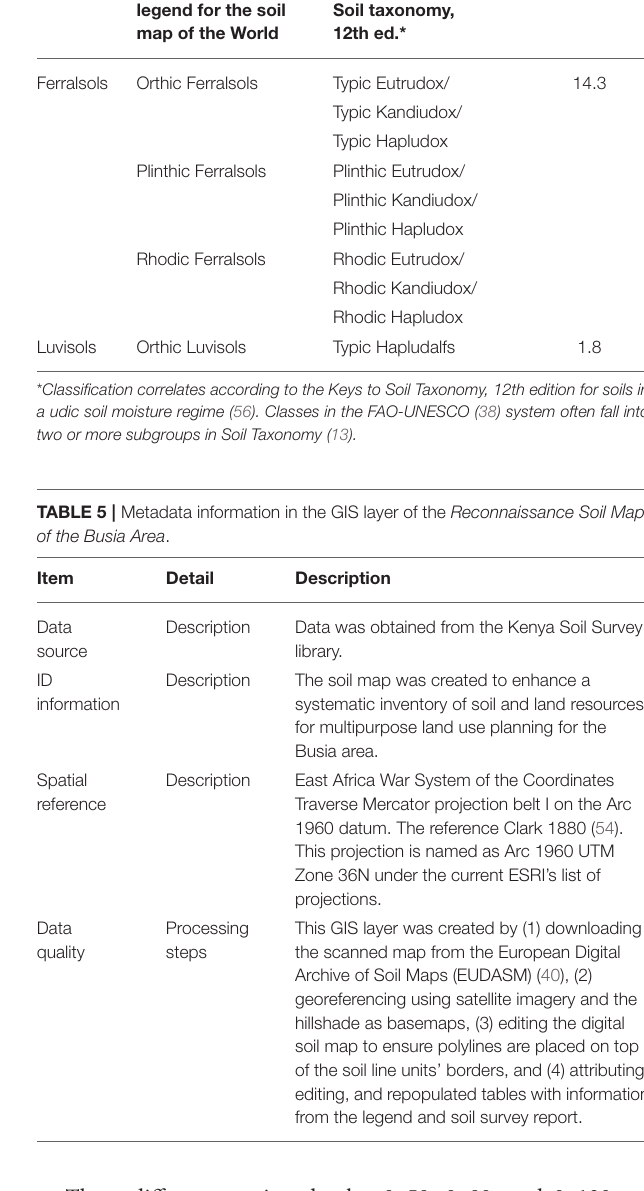
TABLE 4 | Soil orders and soil classes of the Busia area according to the Legend for the Soil Map of the World (38) and correlates to the Soil Taxonomy, 12th edition (13).